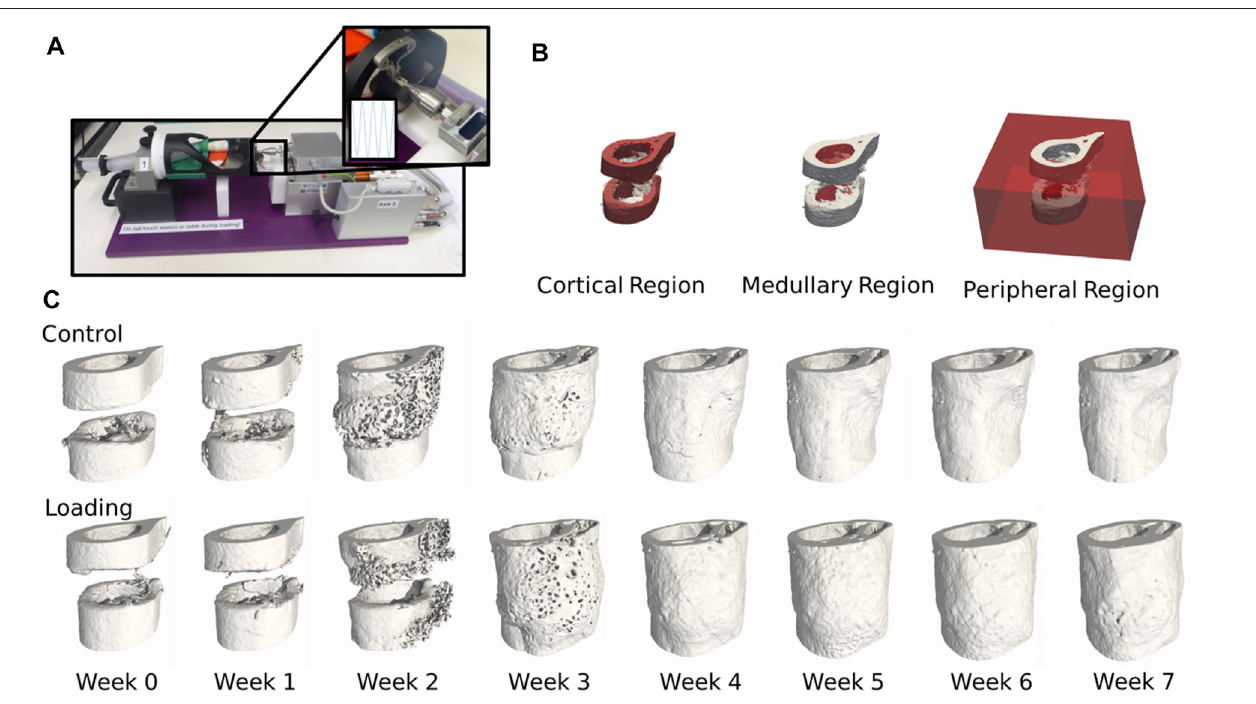
FIGURE 1 | (A) Femur defect loading was performed by an electromagnetic actuator, a specially designed holder, and an external fi xator (Wehrle et al., 2021). (B) Three mask regions at week 0 of the femur defect regions. (C) Temporal progression of femur defect healing of both control and loaded mice.